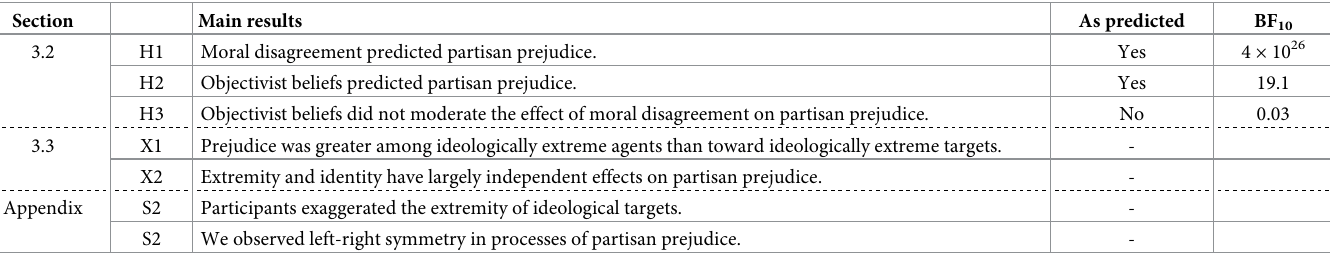
Table 2. Overview of key